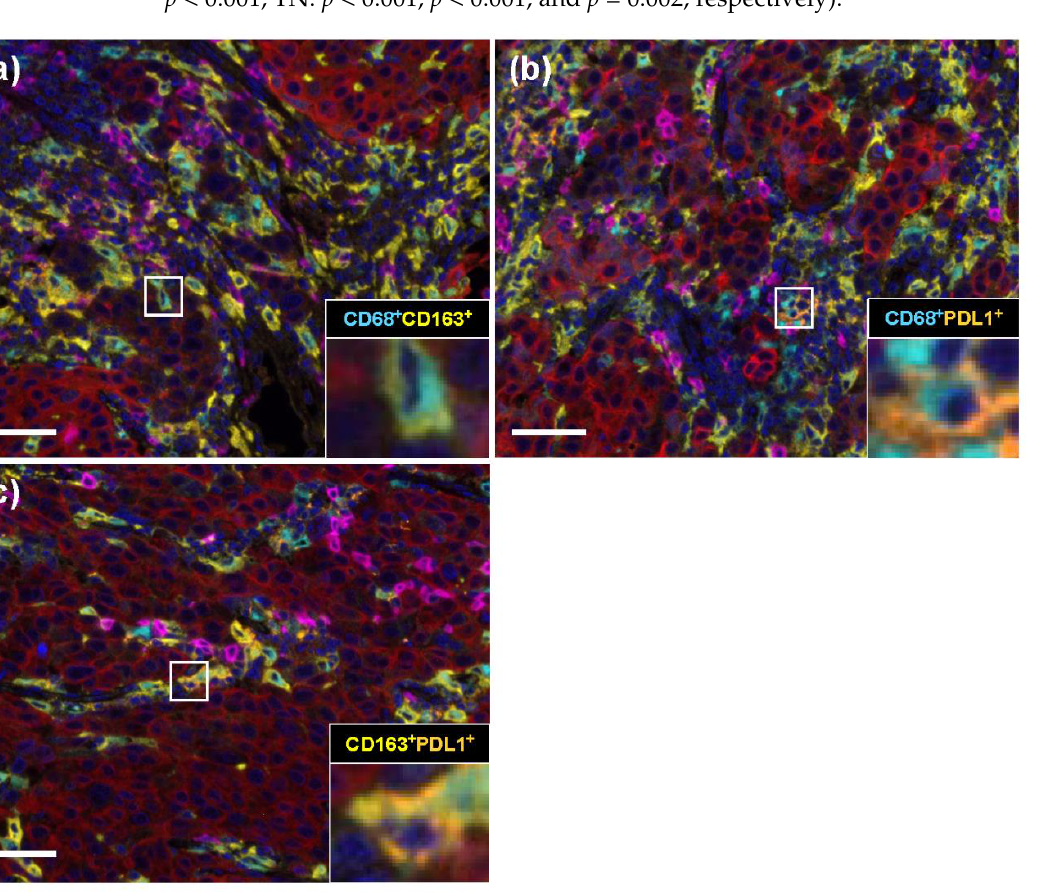
Figure 2. Representative TAMs and immune modification marker double-positive cells obtained using automated quantitative pathology imaging system and image analysis software. Representative images of immunostained double-positive cells: ( a ) CD68 (blue)/CD163 (yellow), ( b ) CD68 (blue)/ PD-L1 (orange), and ( c ) CD163 (yellow)/PD-L1 (orange) double-positive cells in breast cancer tissues. Scale bars indicate 100 μm.